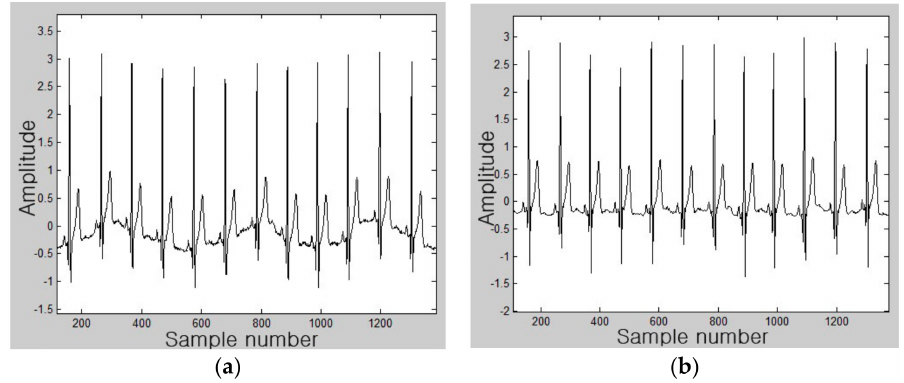
Figure 4. Pre-processing result: ( a ) Original signal; ( b ) Signal with daubechies used.